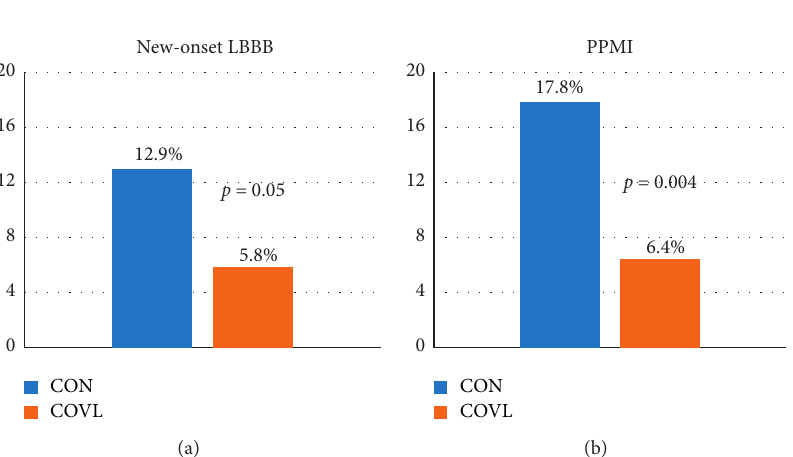
Figure 3: Conduction disturbances after TAVR using cusp-overlap view vs. conventional 3-cusp coplanar view. 30-day new-onset LBBB and permanent pacemaker implantation rate using cusp-overlap projection for TAVR in comparison with the standard 3-cusp coplanar projection view using self-expandable THV. LBBB � left bundle branch block; THV � transcatheter heart